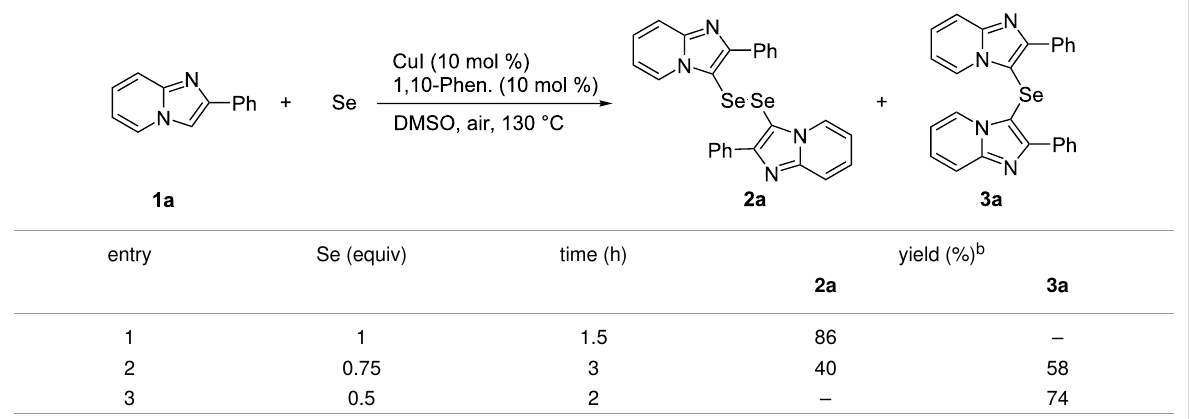
selenide or diselenide can be prepared by carefully selecting the amount of selenium powder under otherwise identical reaction